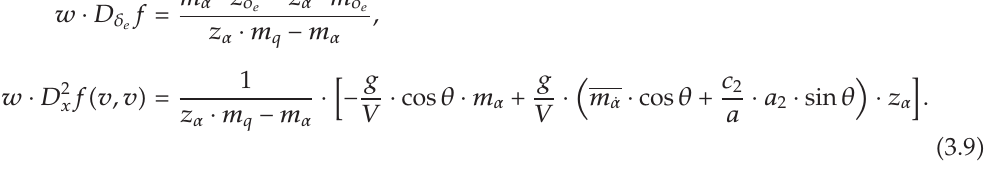
(cid:7) 0 . 048 (cid:5) rad (cid:6) (cid:7) 2 . 751 ◦ < δ e